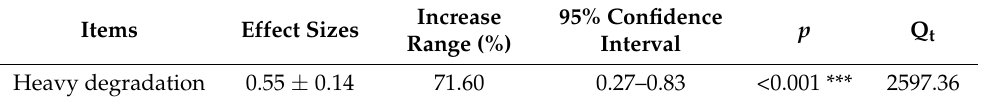
Table 2. Effect size of high degradation on alpine meadow N 2 O rates on the Tibetan Plateau. Items Effect Sizes